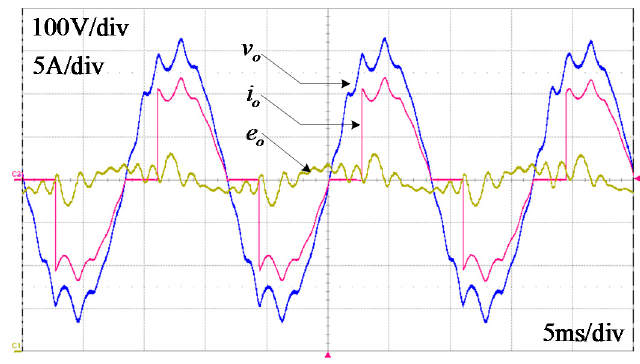
Figure 17. Experimental result without the active damping control.